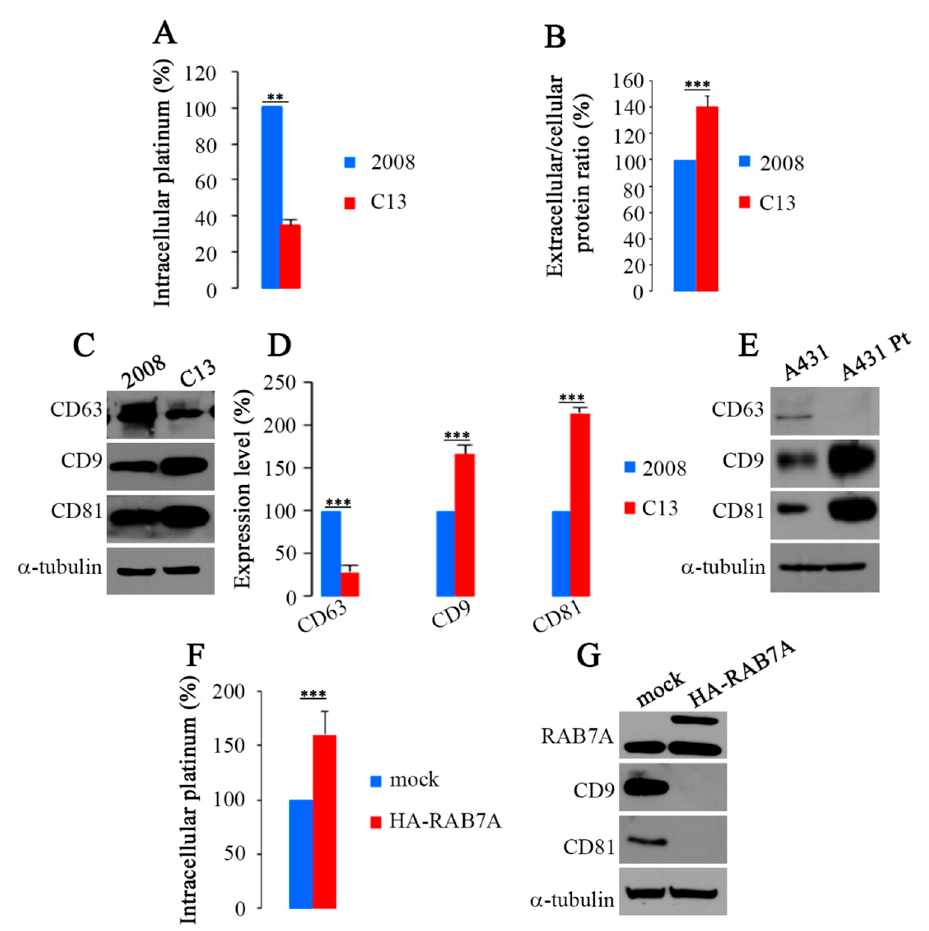
Figure 3. ( A ) Accumulation of platinum in 2008 and C13 cells was measured by Inductively Coupled Plasma-Atomic Emission Spectroscopy (ICP-AES) after treatment with 20 µ M CDDP for 24 h. Obtained values were normalized on cell number. ( B ) Total amount of extracellular proteins released from 2008 and C13 cells normalized on total cell proteins. ( C,D ) Relative amounts of CD63, CD9 and CD81 were examined by WB and quantified. ( E ) Expression of CD63, CD9 and CD81 on extracellular vesicles (EVs) from A431 and A431 Pt cells. ( F ) Platinum accumulation in C13 (mock) or C13 expressing HA-RAB7A was measured by ICP-AES after 24 h of treatment with 20 µ M CDDP. ( G ) Expression of CD9 and CD81 was evaluated on EVs from mock and HA-RAB7A transfected C13 cells. Data represent the mean ± SE. of at least three independent experiments. ** p ≤ 0.01 and *** p ≤ 0.001